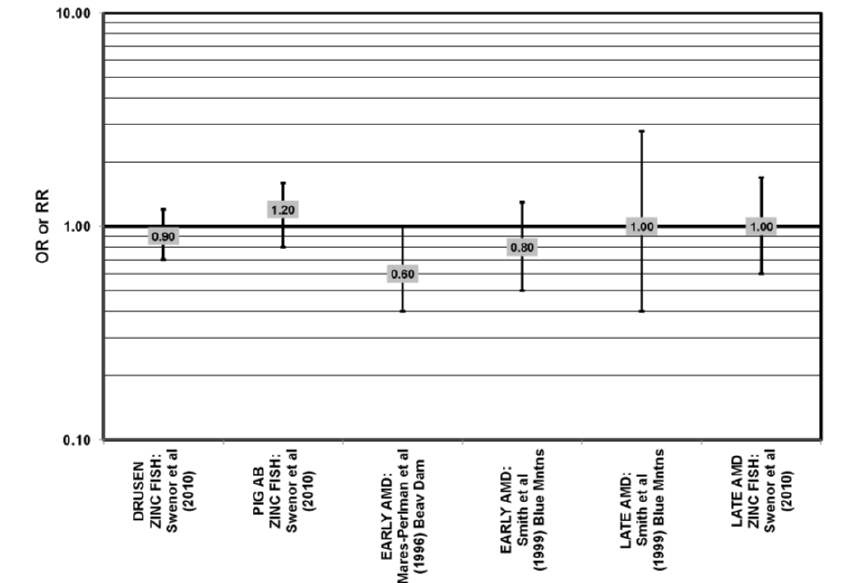
low intake of zinc: retrospective and cross-sectional studies.